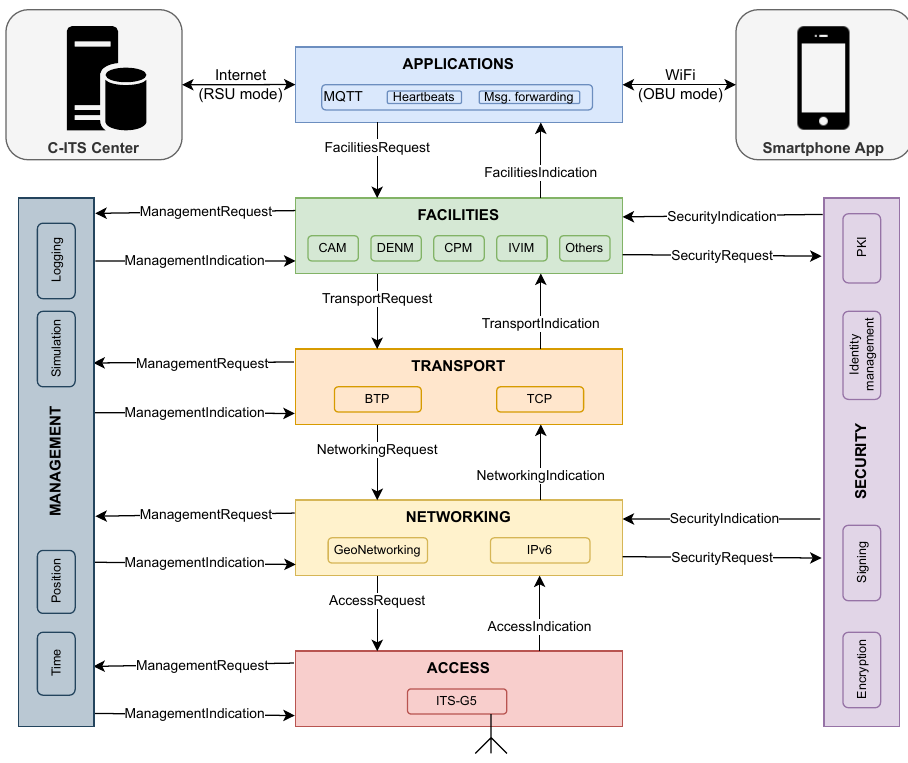
Figure 3. Implemented ETSI ITS-G5 protocol